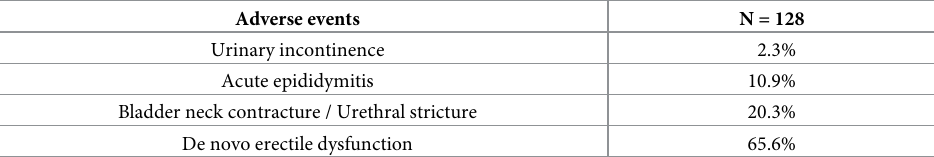
Table 7. Adverse events after primary HIFU.